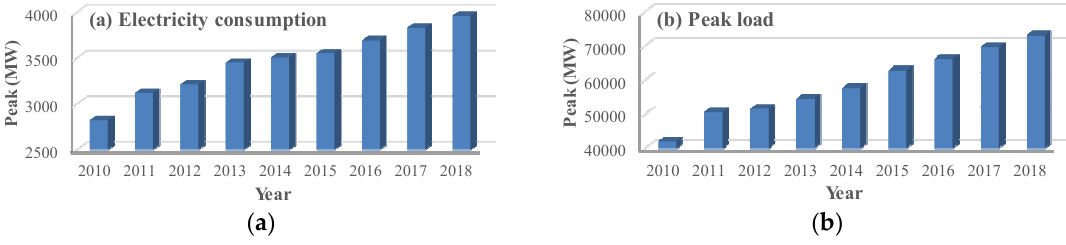
Figure 1. Electricity consumption and peak load of Zhejiang power grid from 2010 to 2018. ( a ) Electricity consumption ( b ) Peak load.